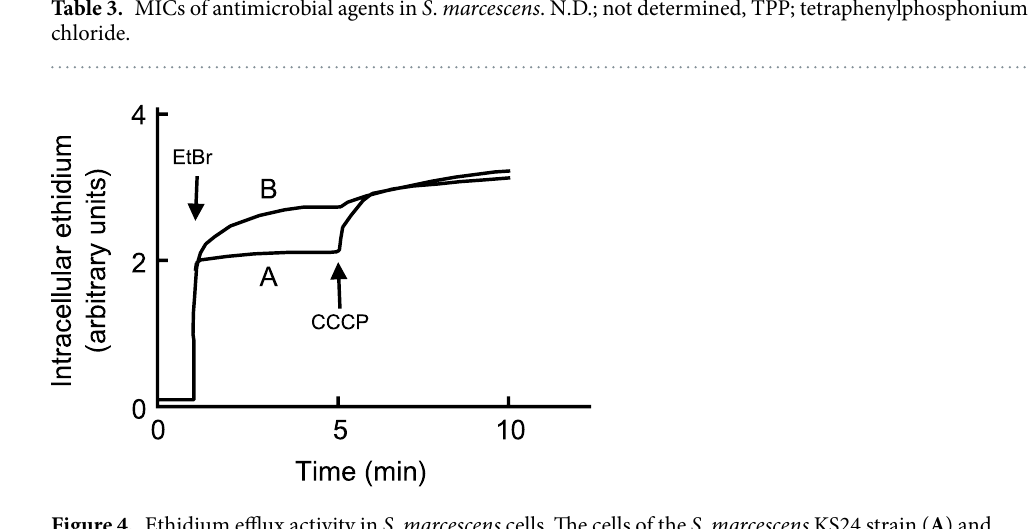
Figure 4. Ethidium efflux activity in S . marcescens cells. The cells of the S . marcescens KS24 strain ( A ) and its KS24 ∆ sdeXY ( B ) were prepared as described in the Materials and Methods. Ethidium bromide was added to cell suspensions at a final concentration of 10 μ M at the time point indicated by the first downward arrow. Intracellular ethidium levels were monitored continuously by measuring the fluorescence of ethidium at excitation and emission wavelengths of 500 and 580 nm, respectively. At the second downward arrow, CCCP was added to the suspensions at a final concentration of 100 µ M. Assays were performed at 37